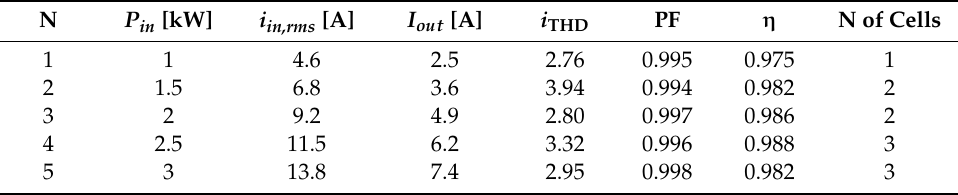
Table 3. Main IBPFC Electrical quantities at a di ff erent input power.